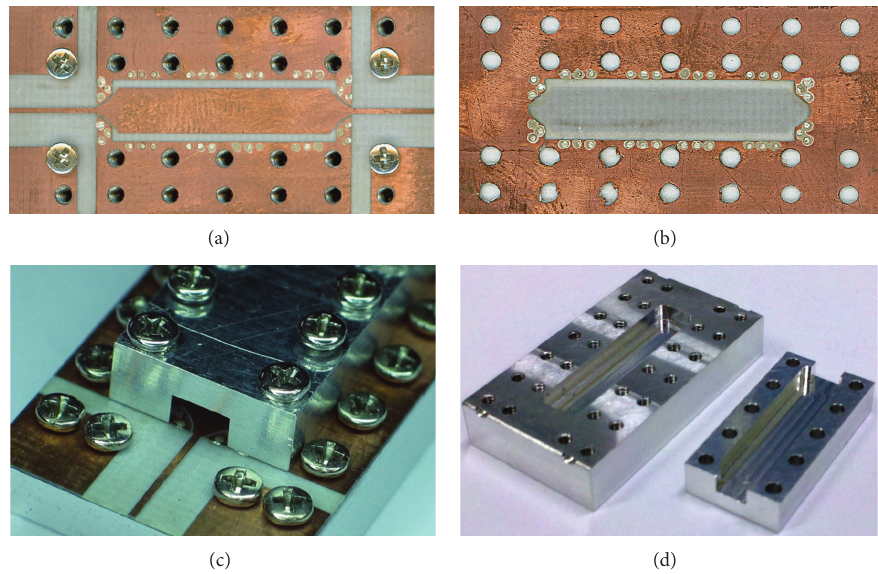
Figure 11: Picture of the fabricated ultrawideband MSL-to-SSL transition in a back-to-back configuration: (a) top view, (b) bottom view, (c) cover and bottom carrier, and (d) perspective view of